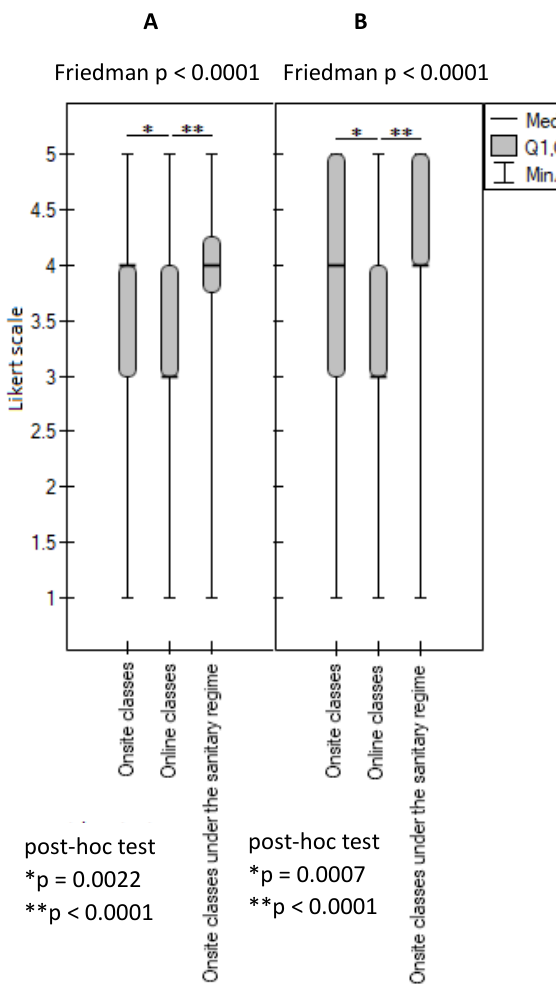
Figure 5. Evaluation of the learning outcomes achieved in the scope of: ( A ) communication with patients of the developmental age and their parents; ( B ) history taking from a patient and/or their family. *, ** p -value is given for statistically significantly different groups. For groups with no significant differences ( p ≥ 0.05), the p -values are not quoted.